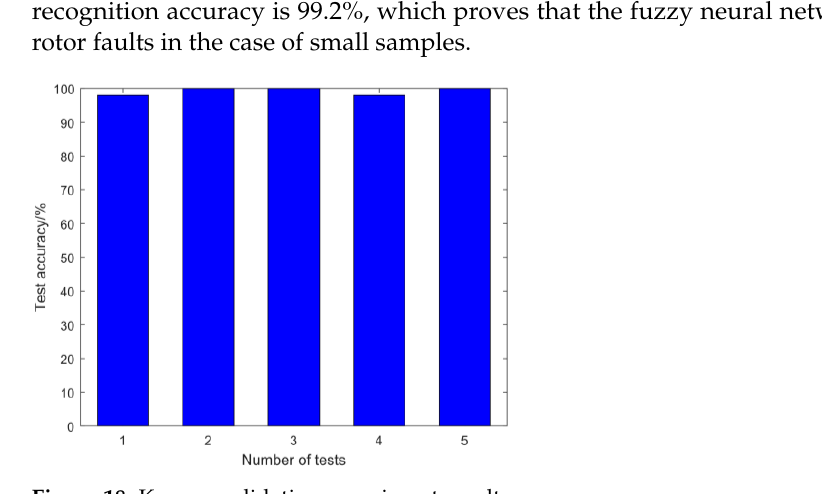
Figure 18. K-cross-validation experiment results. Table 8. Average recognition precision and calculation times of the four classifiers.